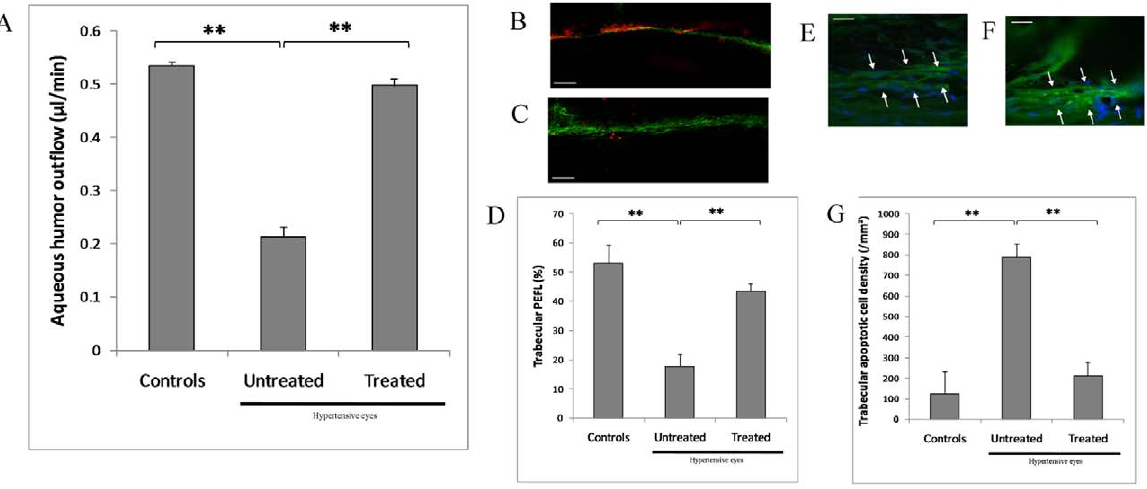
Figure 5. Ophthalmic administration of CXCR3 antagonist restores trabecular filtrating function and protects trabecular cells from apoptosis in a rat model of ocular hypertension. (A) Aqueous humor outflow impairment in hypertensive eyes is counteracted by treatment with CXCR3 antagonist as measured in vivo by fluorophotometry (n=10 each). (B,C,D) Trabecular filtrating function is restored by treatment with CXCR3 antagonist as assessed by trabecular trapping of fluorescent microspheres (red), and quantitatively measured as percent of effective filtration length (PEFL), which is more important in treated eyes (B) than in untreated hypertensive eyes (C) (n=10 each). (E,F,G) Density of apoptotic trabecular cells is lower in eyes treated with the CXCR3 antagonist (E) than in untreated hypertensive eyes (F), as assessed by TUNEL (green) and DAPI (blue) nuclear staining (n=10 each). ** P , 0.01. (scale bar, 50 m m). Data in bar graphs are presented as means 6 SEM.